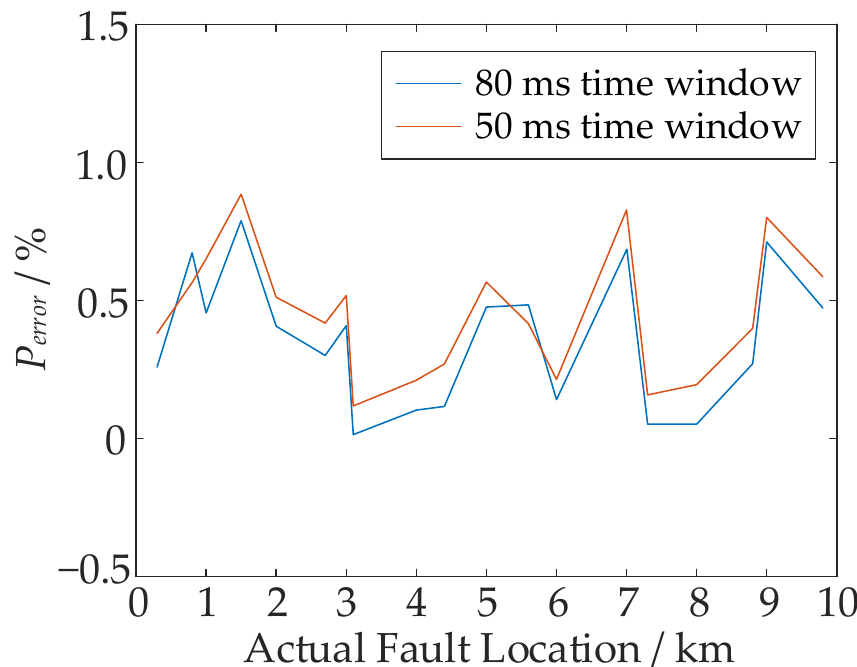
Figure 12. Fault location results and errors with data window length.